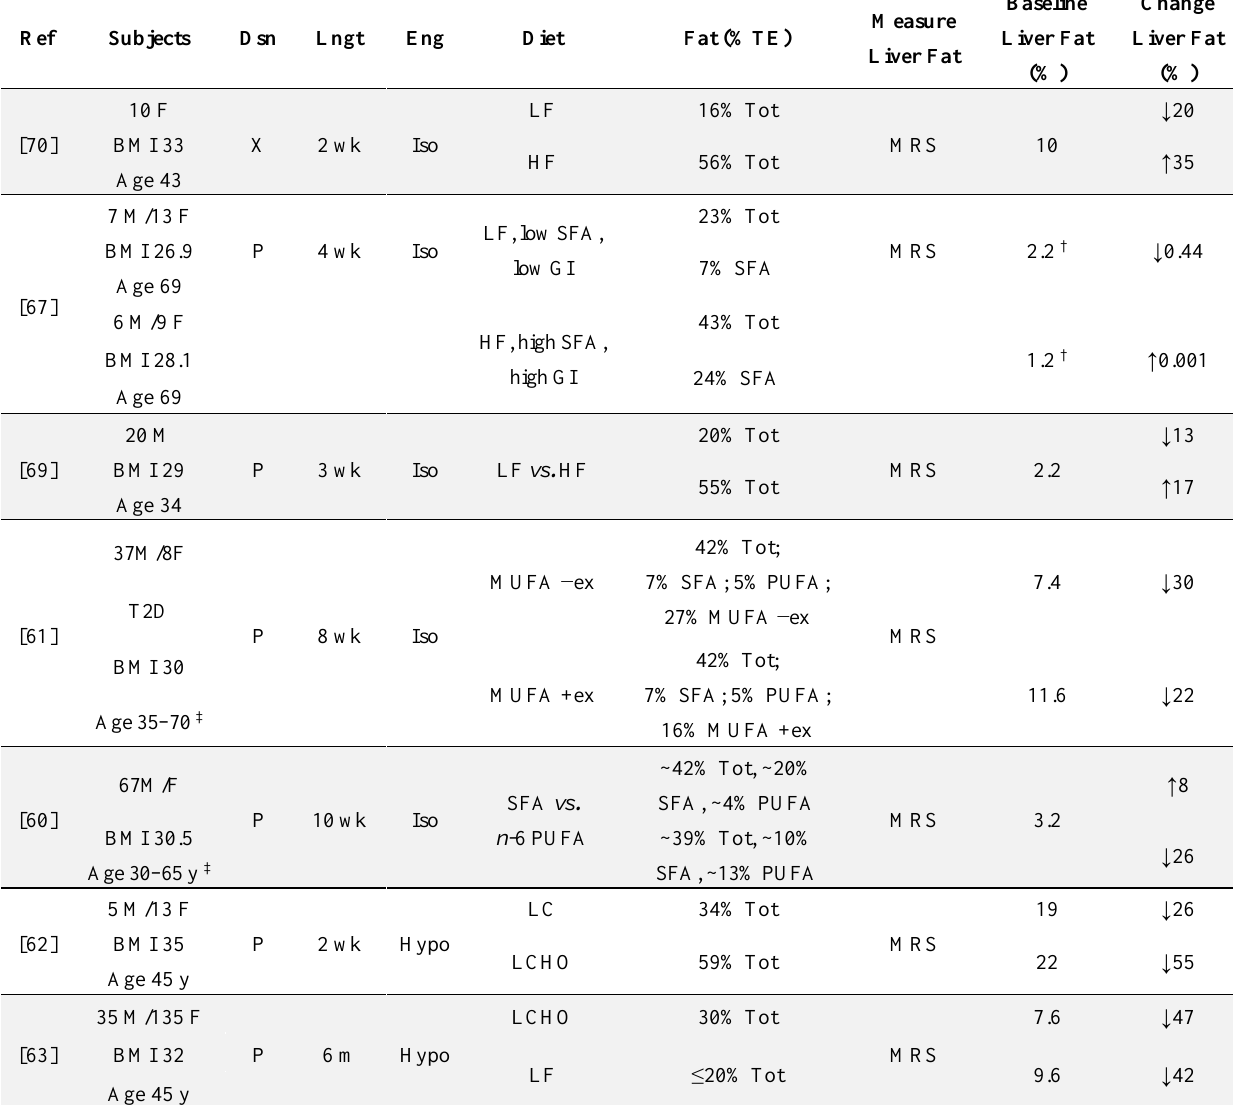
Table 1. Overview of intervention studies that have investigated the effect of dietary fat on liver fat